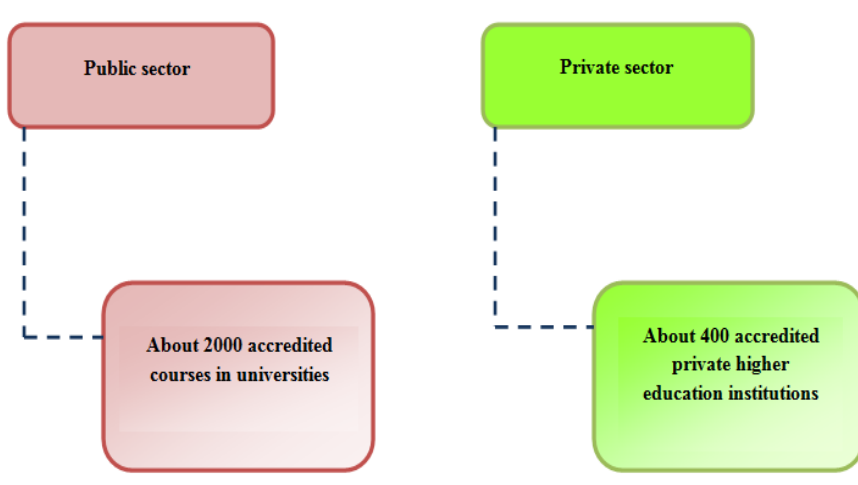
Fig. 3. Overview of Higher Education in Morocco